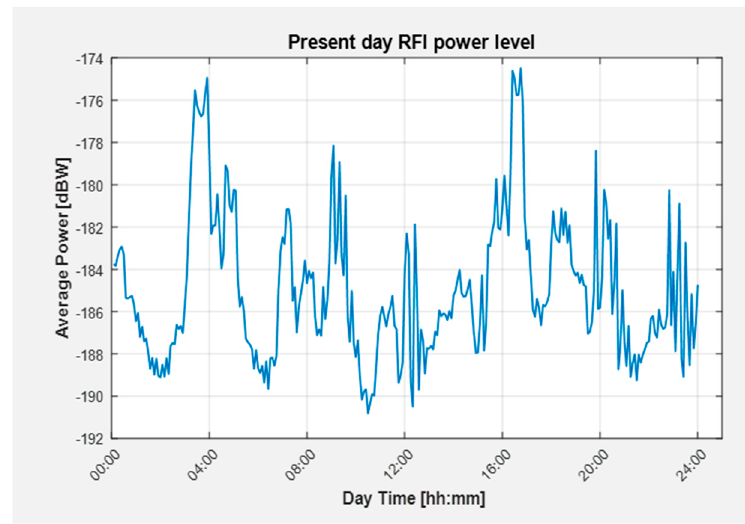
Figure 7. Hourly estimation of the mean LEO-to-GEO RFI power, due to the 30 LEO-SAR in Table 1.